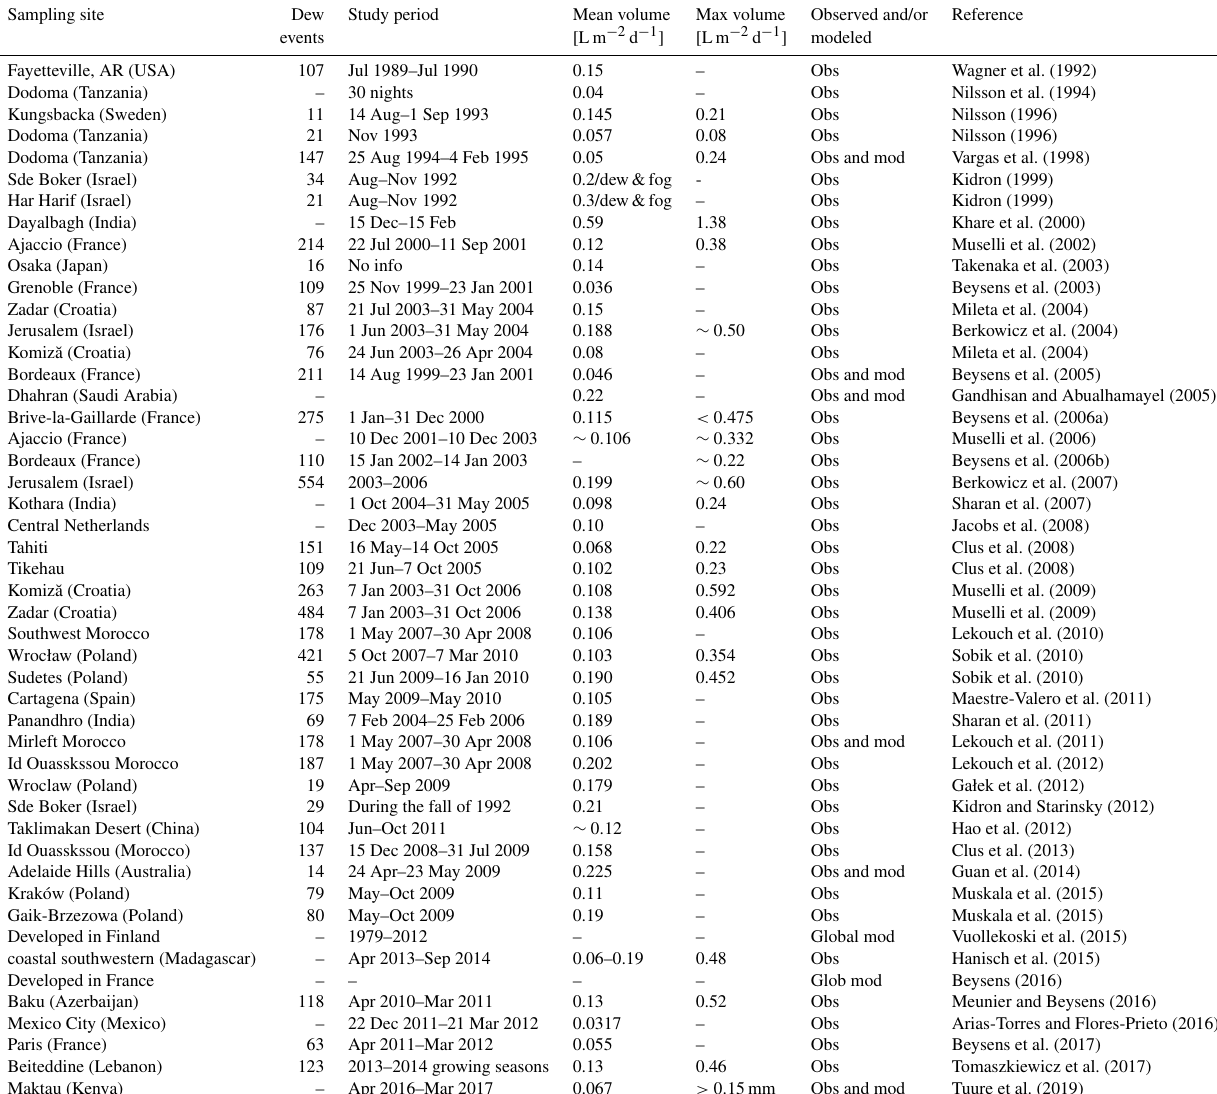
Table 1. Dew yield from plane radiative condensers in various field campaigns and models. Sampling